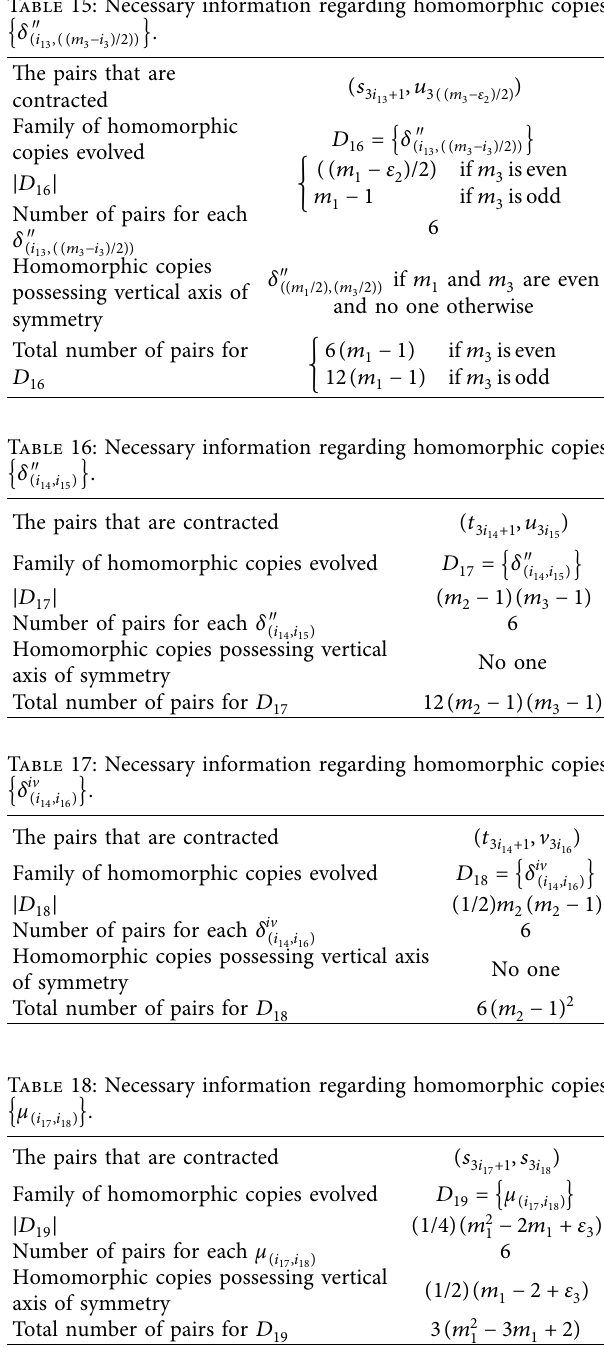
Table 15: Necessary information regarding homomorphic copies